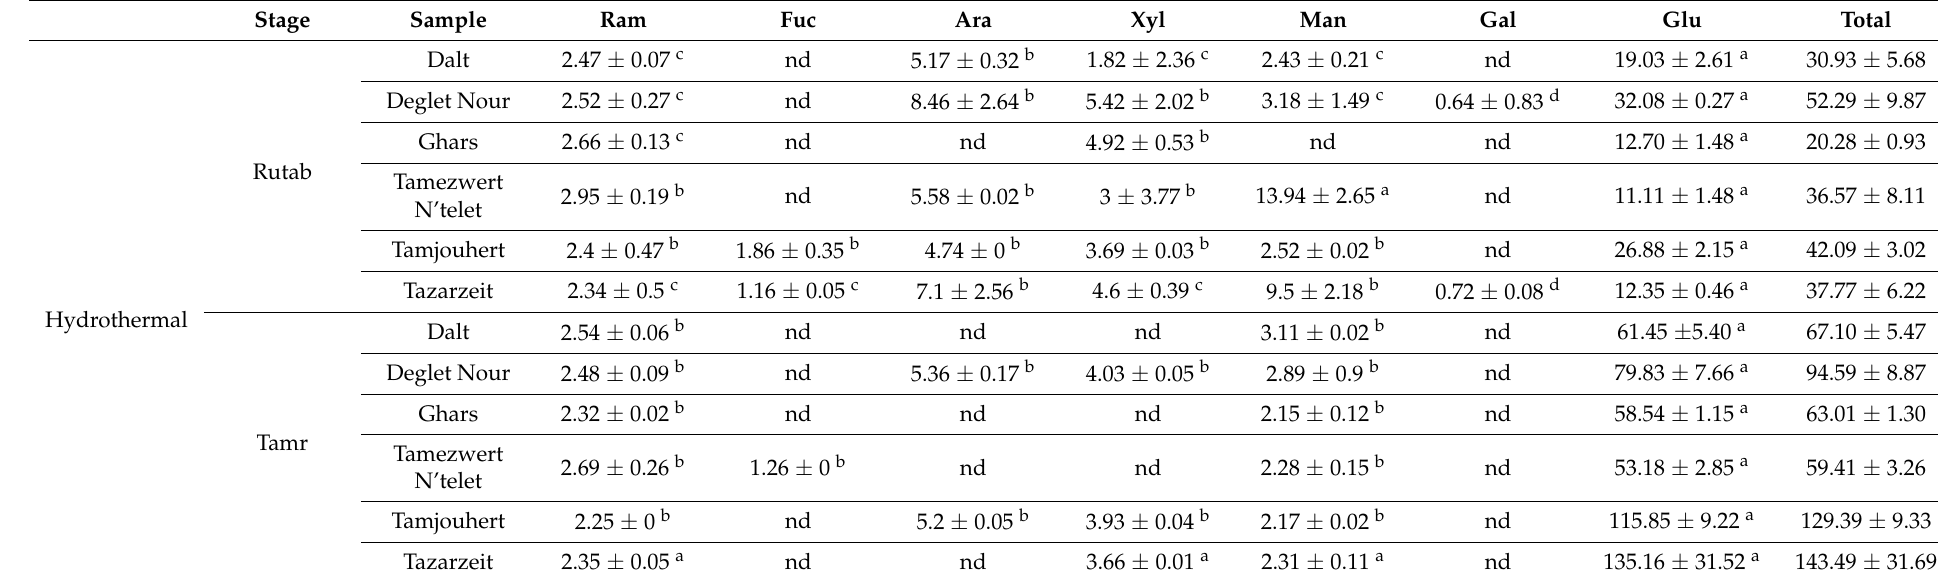
Table 2. Individual sugar (mg/kg DW) in all varieties and stages for the three extraction systems.